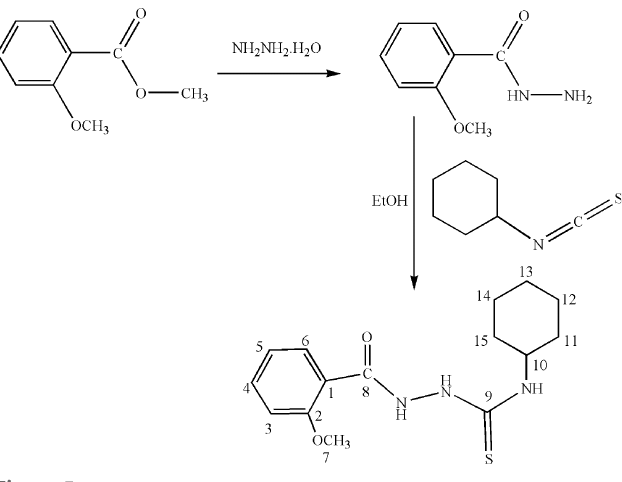
Figure 5 The reaction scheme showing the synthesis of the title compound.